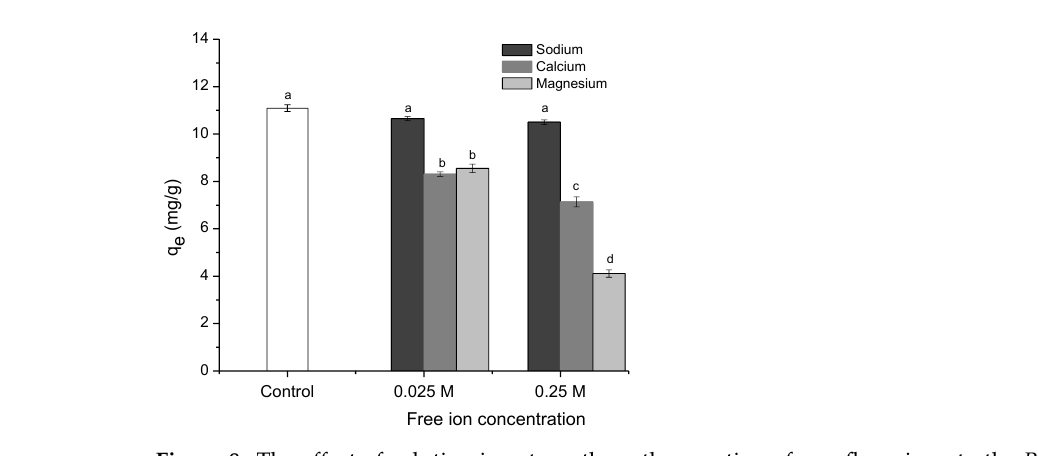
. Figure 7. The effect of solution pH on the sorption of enrofloxacin onto P. koidzumii sorbent (adsorbent dose 8 g/L; 100 mg ENR/L; contact time 40 min; and temperature 298 K). Those means that do not share a common superscript differ significantly (Tukey p < 0.05). 2.2.5. Effect of Solution Ionic Strength The effects of three common salts (NaCl, CaCl 2 , and MgCl 2 ) and their respective dis- sociated ions on the ENR adsorption capacity were investigated. The salts were evaluated at free ion concentrations of 0.025 and 0.25 mol/L. As displayed in Figure 8, Na + (at both free ion concentrations tested) did not significantly affect ( p > 0.05) the biosorption of ENR to any significant extent. However, at a free ion concentration of 0.025 mol/L, both the Ca +2 and Mg +2 ions reduced the adsorption capacity by 24%. Furthermore, as the divalent ion concentration increased to 0.25 mol/L, the adsorption capacity was significantly affected (up to 63%). The detrimental effect of the Mg 2+ ions on the adsorption capacity of ENR was more pronounced than that of the Ca 2+ ions suggesting the following: (a) similar bind- ing sites, meaning competition between the Mg 2+ ions and ENR for the adsorption sites,